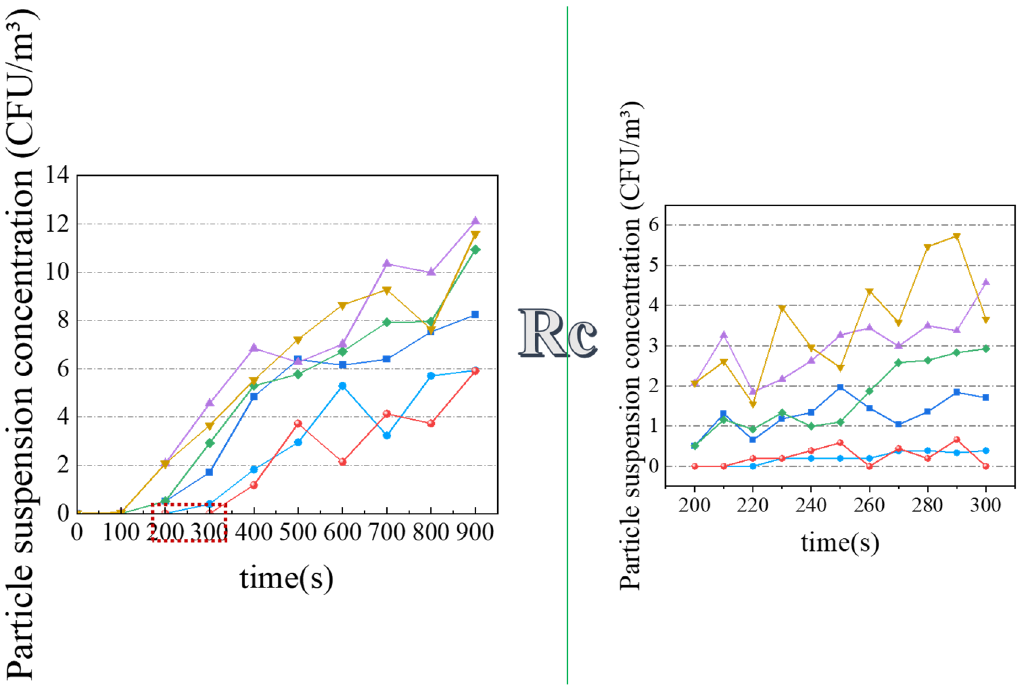
Figure 6 . Concentration changes of the BPs in main champers at different heights. Figure 6. Concentration changes of the BPs in main champers at different heights.